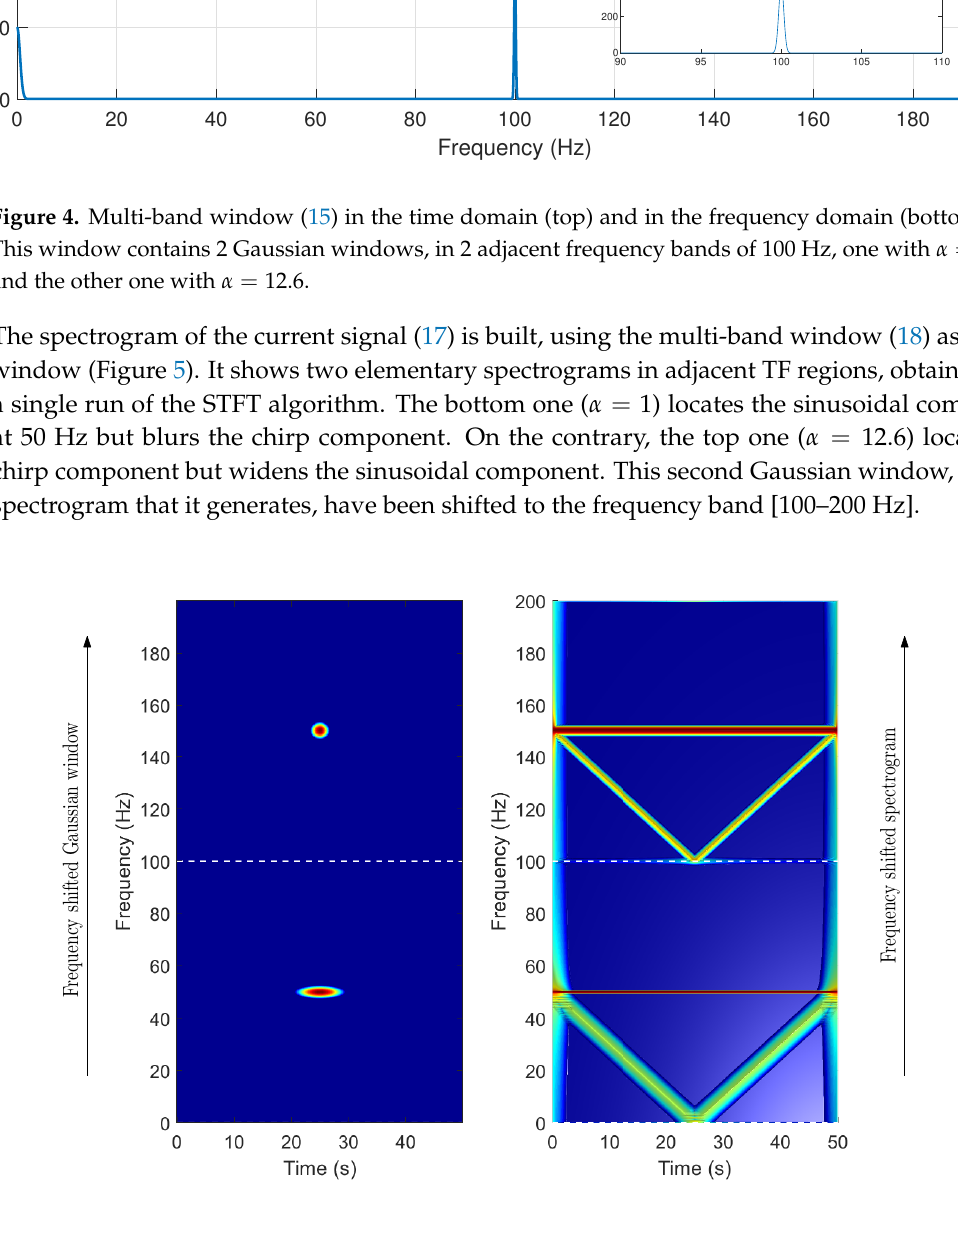
Figure 5. Spectrogram of the current signal (17) obtained in step 2 with the multi-band window (right). The Gaussian component of the window with α = 1 (bottom, left) locates the sinusoidal component at 50 Hz (bottom, right) but fails to resolve the chirp component. On the contrary, the Gaussian component with α = 12.6 (top, left) locates the chirp component but widens the sinusoidal component (top, right). The Gaussian window that is frequency shifted (left) generates a spectrogram that is also frequency shifted